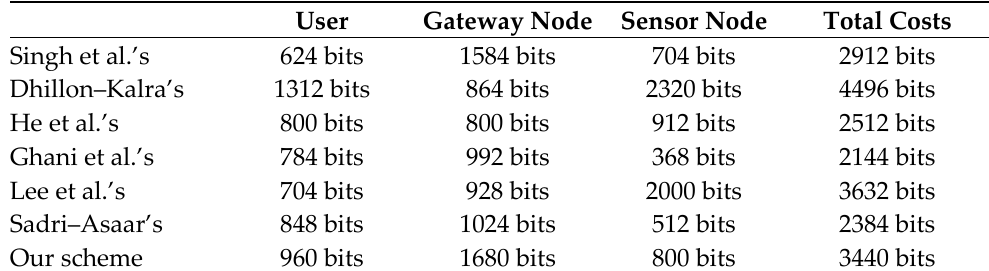
Table 11. Comparison of communication cost.